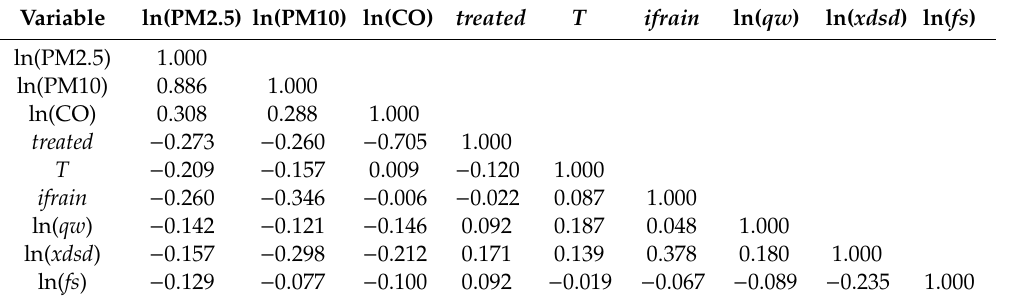
Table 2. The correlation between